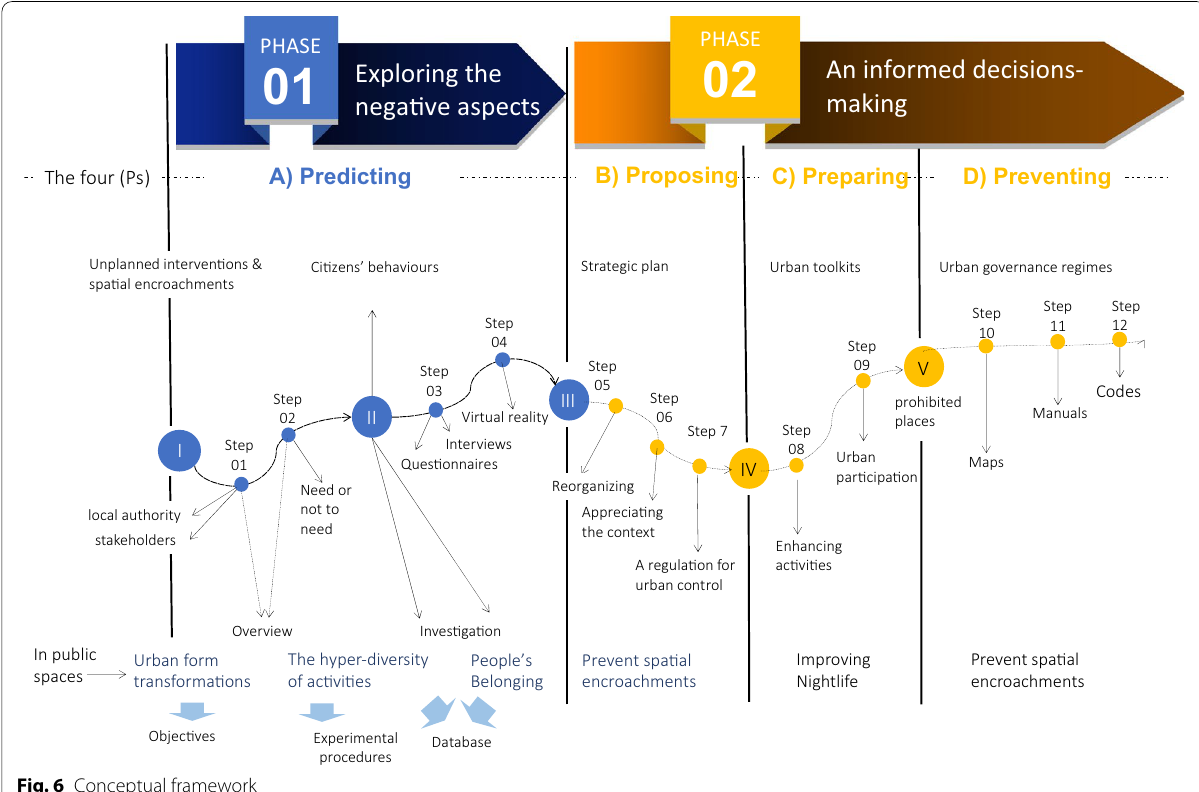
Fig. 6 Conceptual